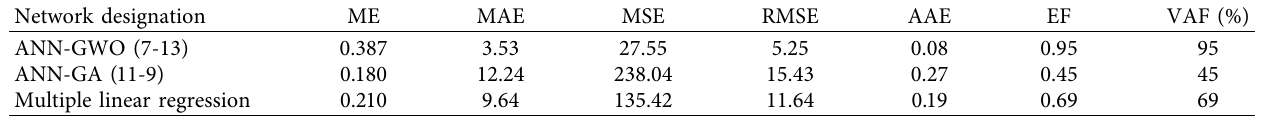
Table 7: Training data statistics of the ANN-GWO, ANN-GA, and multiple linear regression models.